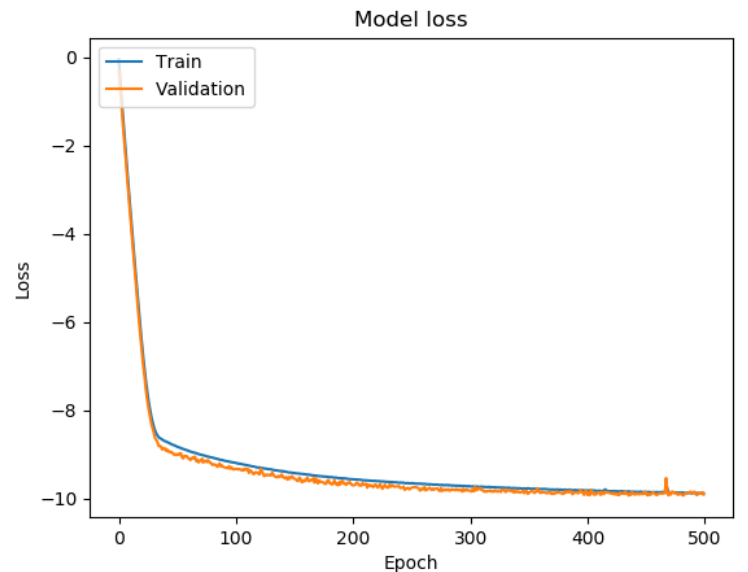
Figure 4. Training and validation loss of the proposed multi-task learning approach using translation vector with quaternion as relative pose representation and translation MAE with quaternion multiplicative error as individual task losses.